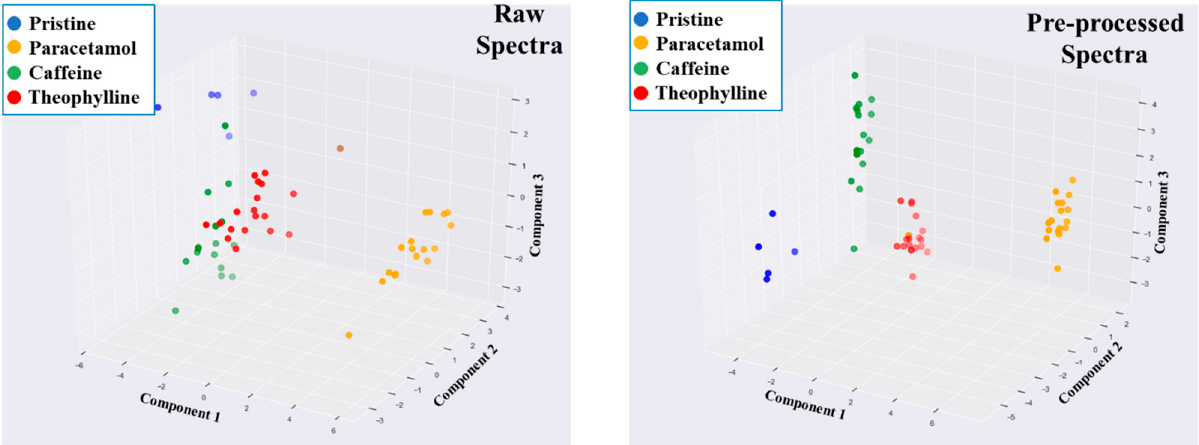
Figure 10. LDA classification of the raw and pre-processed spectra. Pre-processing of the NIR spectra yielded the highest accurate clustering.